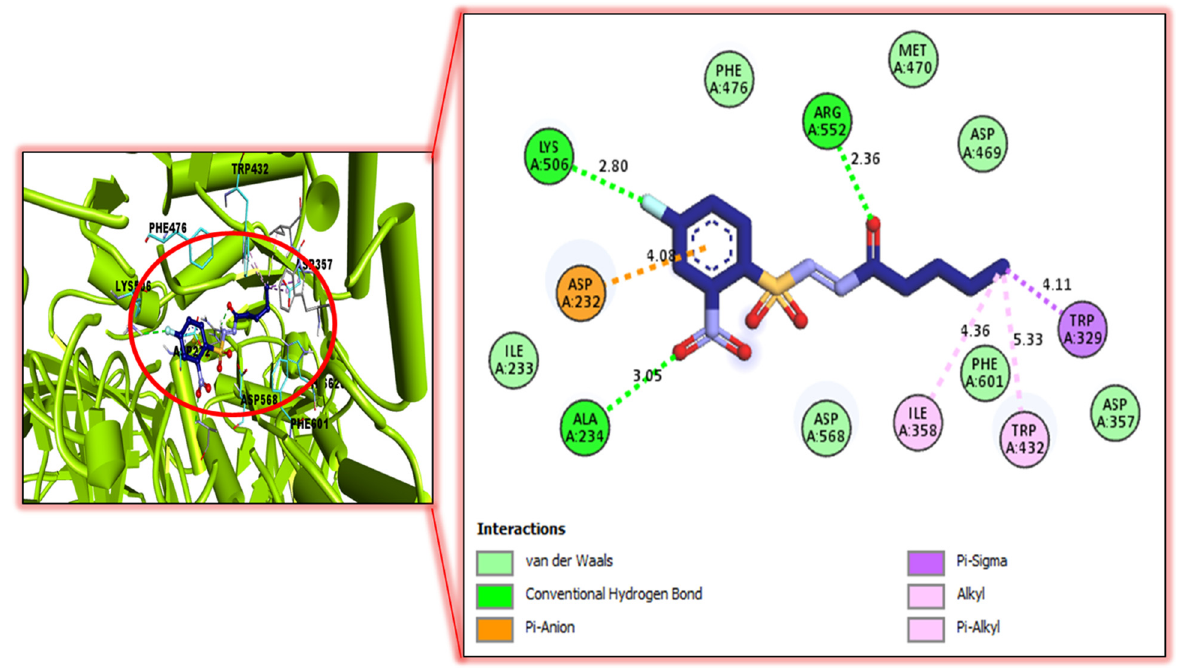
Figure 4. Protein–ligand interaction profile for active analog against urease represents the surface of the corresponding enzyme. The PLI profile for compound 5 .